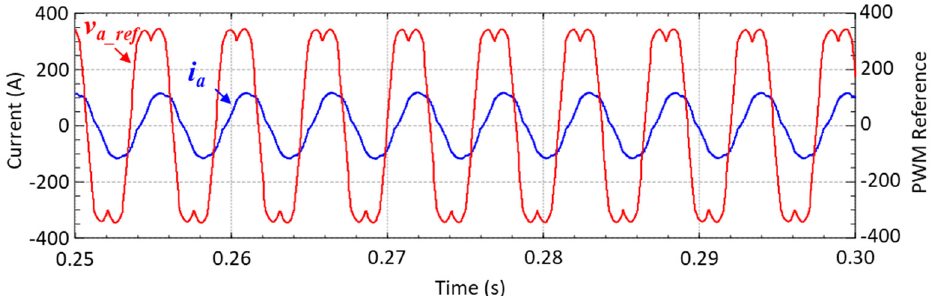
Figure 20. Modulation signal ( t a_ref ) and current ( i a ) in phase a when operating with a nominal me- chanical load.